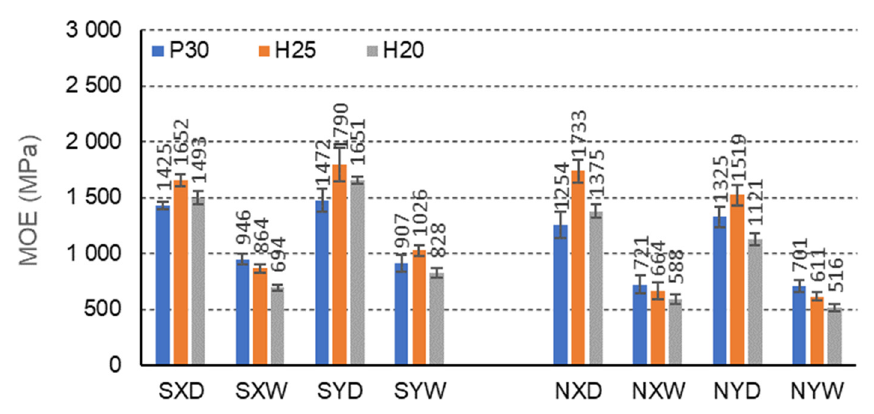
Figure 10. Illustration of the MOE relationship of honeycomb panels with a core of C-cells. Whiskers represent standard deviations.